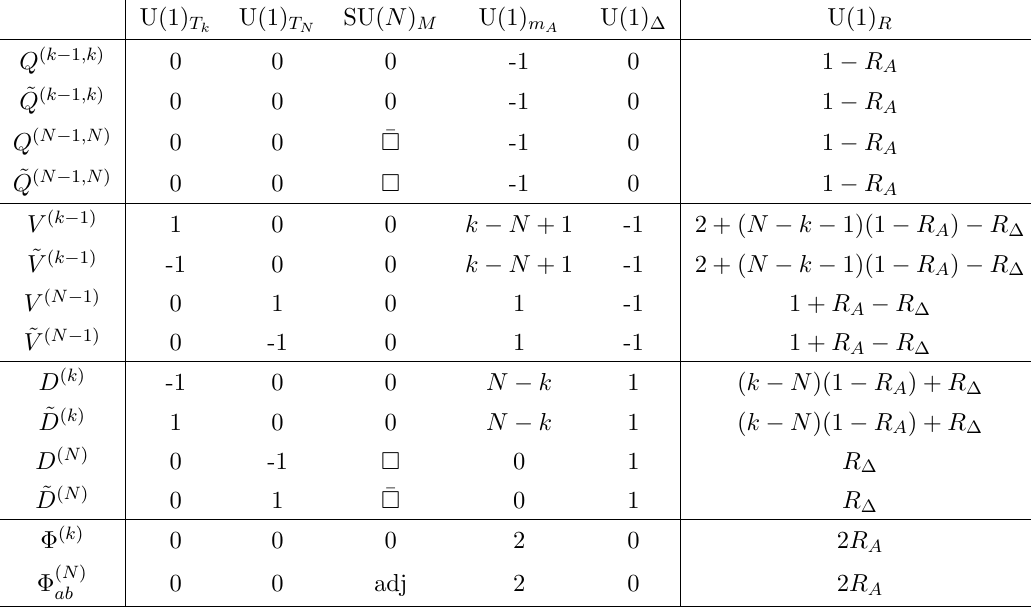
Table 1 . Representations and charges under the global symmetries of all the chiral (cid:12)elds of the FM [SU( N )] theory. In the table, k runs from 1 to N (cid:0) 1. By de(cid:12)nition, Q (0 ; 1) = ~ Q (0 ; 1) = 0 and V (0) = ~ V (0) =